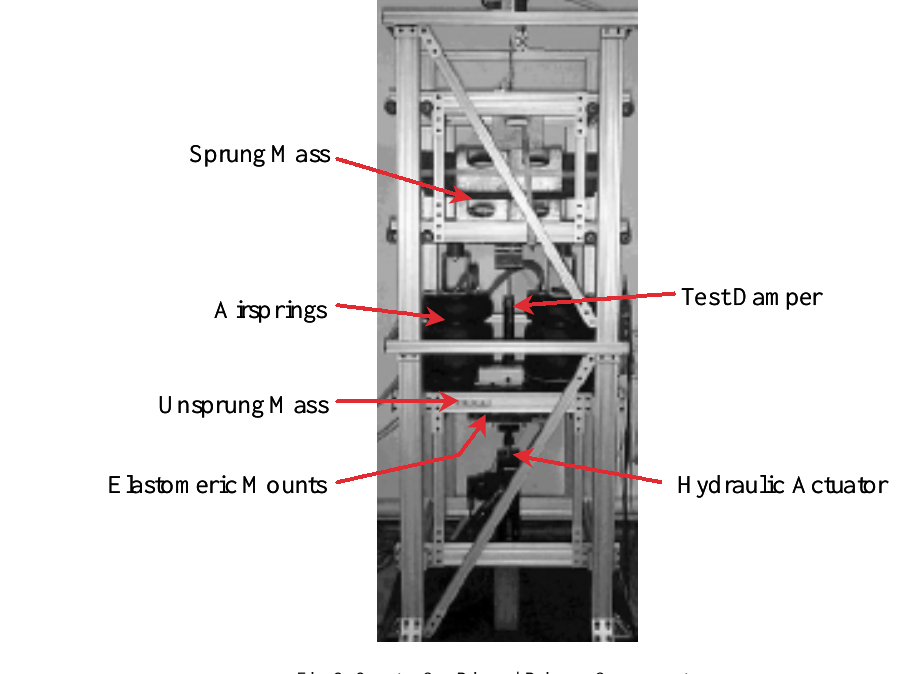
Fig. 2. Quarter-Car Rig and Primary Components.